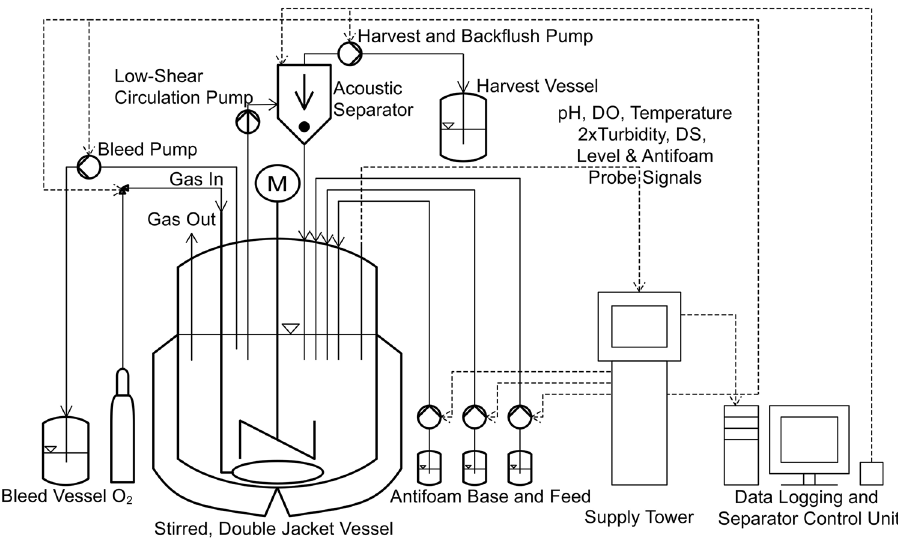
Figure 1. Flow diagram showing the process setup, with tubing represented by solid lines and data transmission represented by dashed